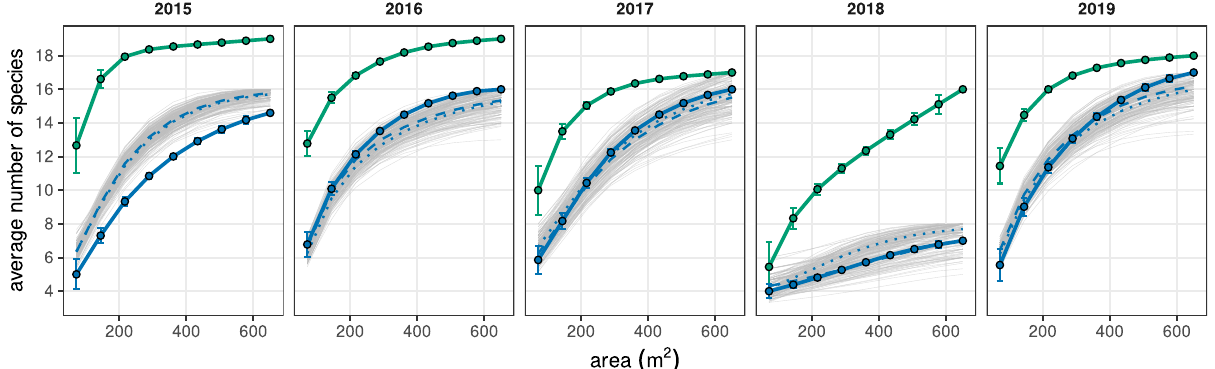
Fig. 4 Null expectations for coexistence – area curves. For reference, species – area curves (green lines and associated dots) and coexistence – area curves with homogeneous parameterization (blue lines and dots) are also depicted. Points represent average values, and error bars represent the standard error of these averages. Null replicates are shown in light gray, and averages of these replicates are shown as dotted lines (null model reshuf fl ing all interaction coef fi cients) and dashed lines (null model keeping intraspeci fi c terms fi xed, and reshuf fl ing interspeci fi c terms). N = 9, 36, 84, 126, 126, 84, 36, 9, 1 combinations of plots, from the smallest to the biggest area,